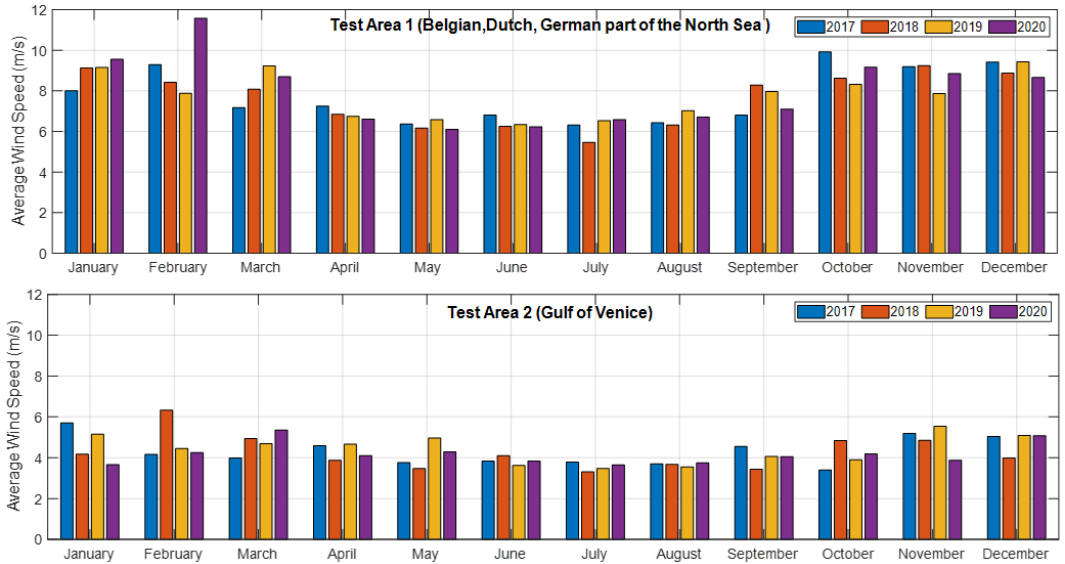
Figure 3. Monthly variation of average wind speed in test areas 1 and 2 for 2017, 2018, 2019 and 2020.